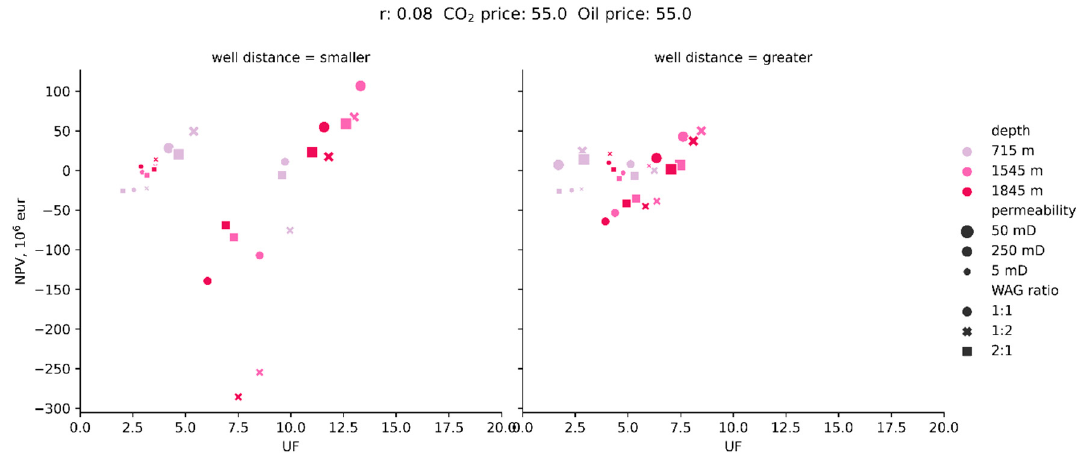
Figure 14. NPV versus UF for the optimistic scenario at the end of EOR with 40 € /MWh electricity price.